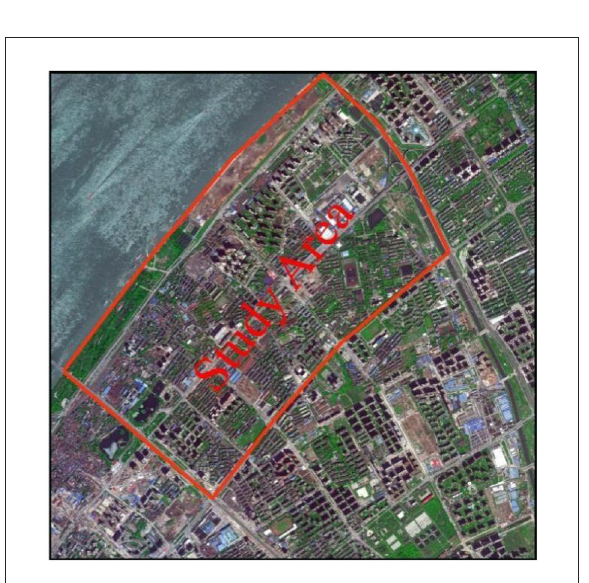
FIGURE7 The Yangyuan Street area in the satellite image.